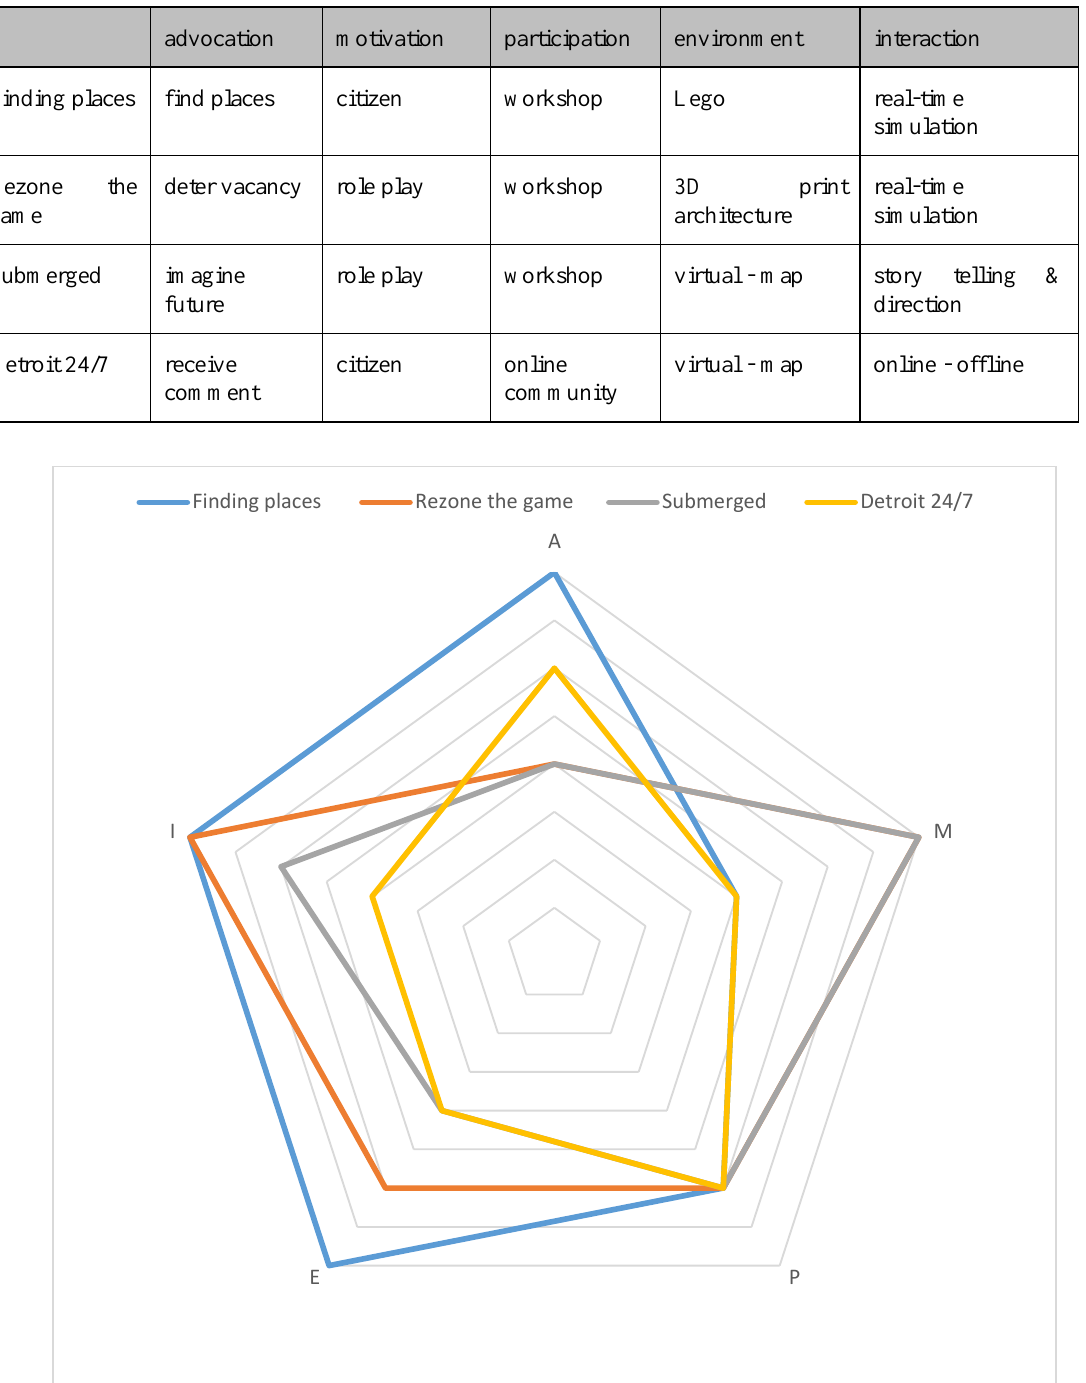
Figure 3. Weighs in cases for each element of the